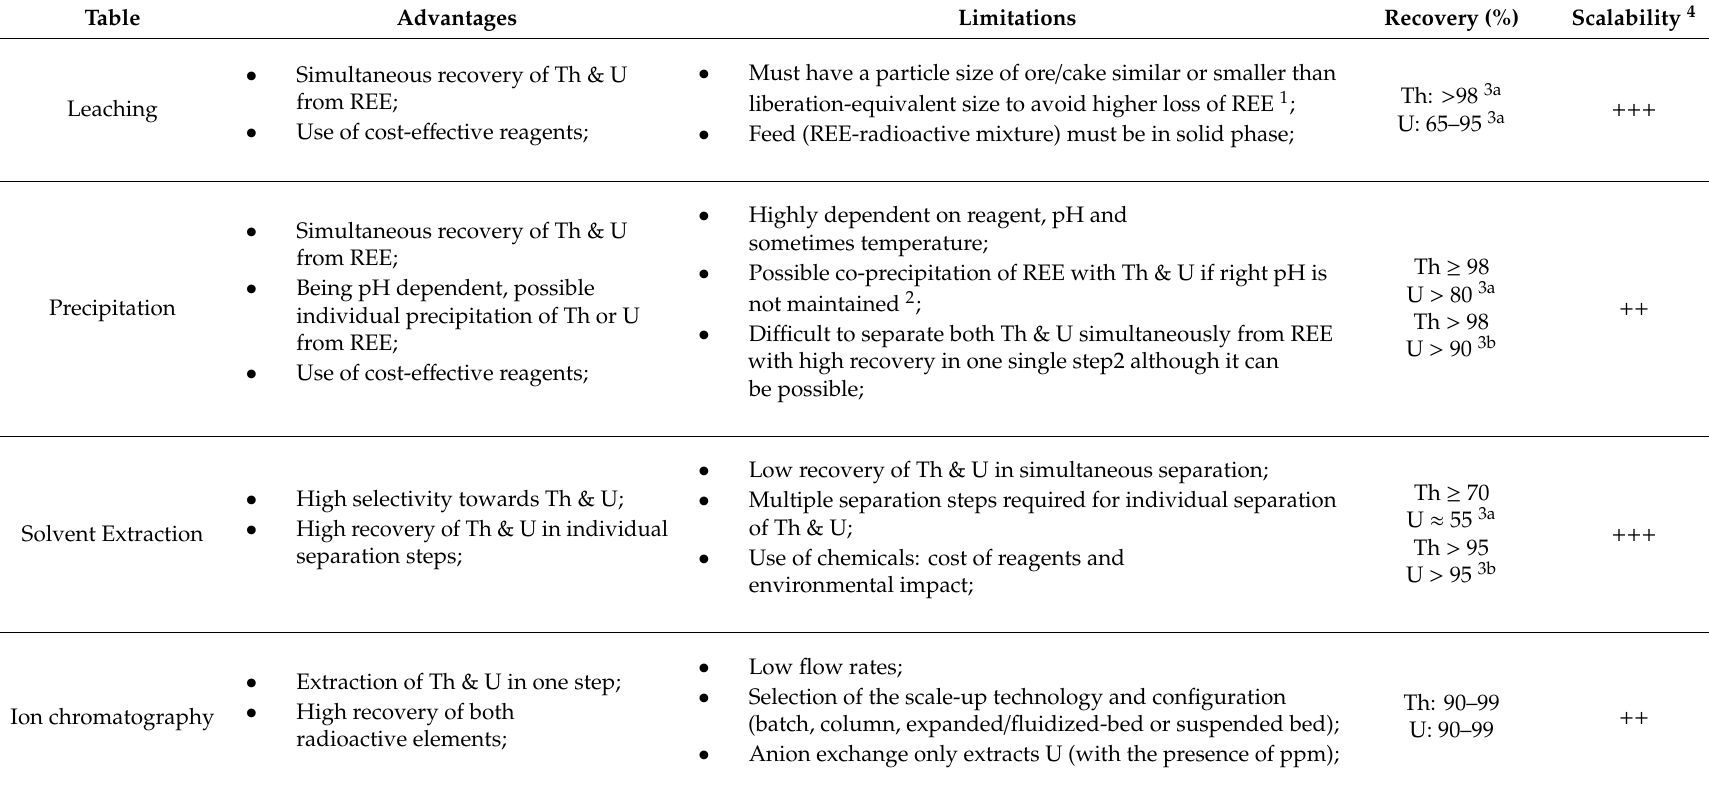
Table 7. Advantages and disadvantages of di ff erent methods for separating radioactive elements from REE.